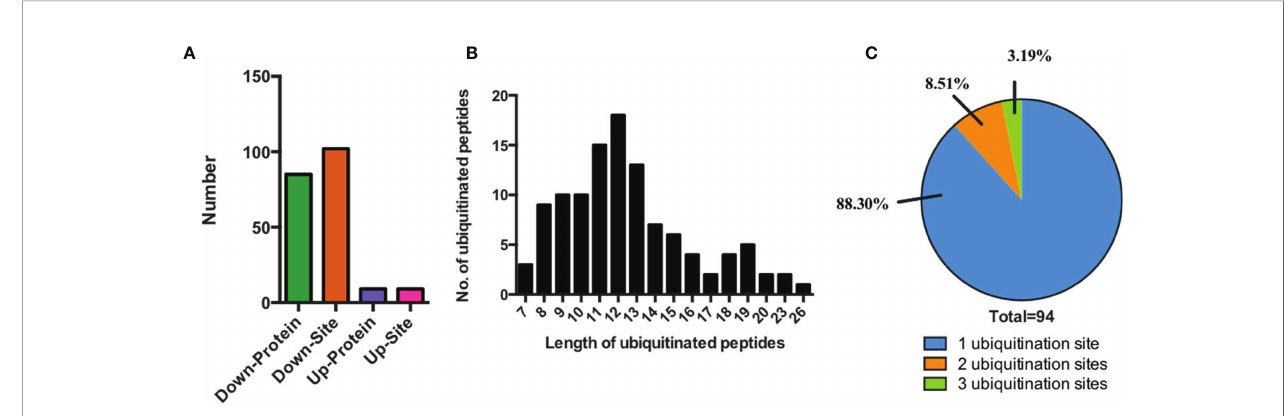
FIGURE 1 | Characteristics of the identi fi ed ubiquitinated peptides between SCAs and FCAs. (A) The number of differently expressed ubiquitinated peptides and proteins. (B) Distribution of ubiquitinated peptides with different length. (C) Distribution of ubiquitinated proteins based on the number of ubiquitination